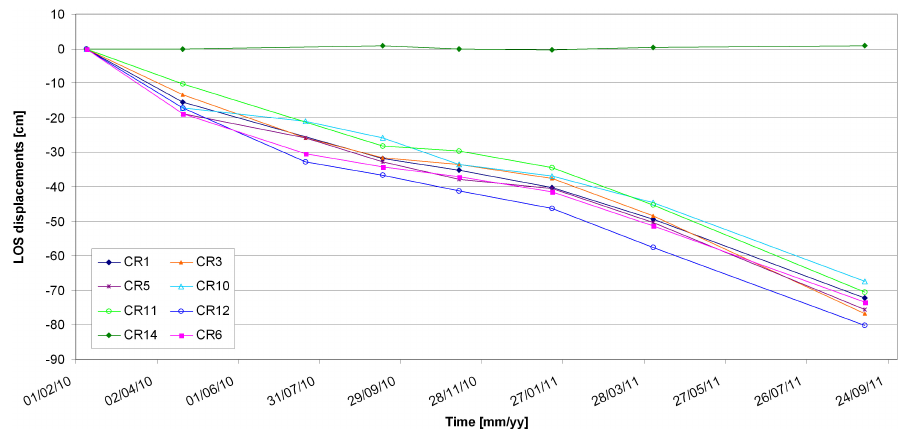
Fig. 7. Measured displacements between February 2010 and September 2011 at eight CRs (see location in Fig. 5). Only those CRs with a full record line are